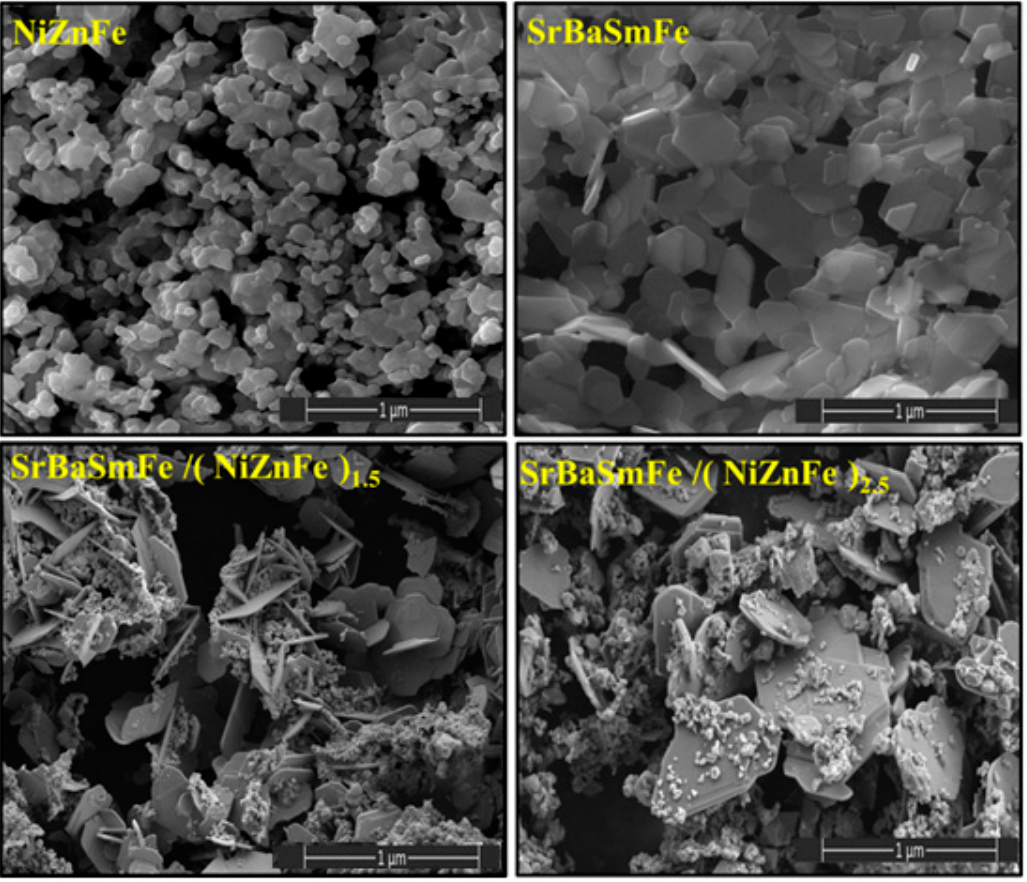
Figure 3. FE-SEM images of pure SrBaSmFe, pure NiZnFe, SrBaSmFe/(NiZnFe) 1.5 NC, and SrBaSmFe/(NiZnFe) 2.5 NC.